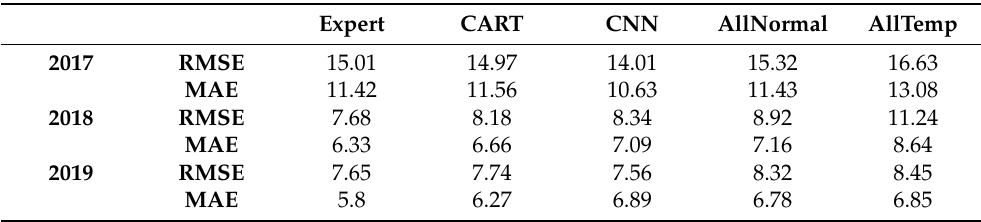
Table 4. PM 2.5 forecast performance of various model strategies with short-term training in seven